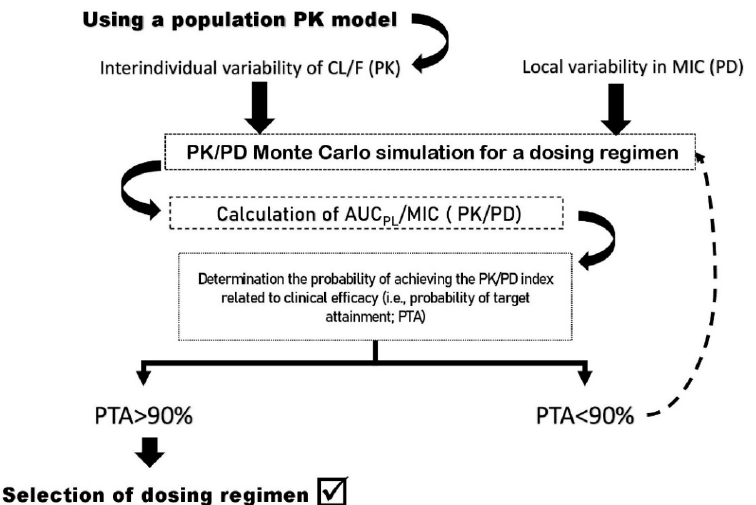
Figure 3. Model-based approach to select FQ dosing regimen based on % probability of target attainment. Scheme of the steps needed to apply PK/PD analysis and Monte Carlo simulation in clinical setting. PK: Pharmacokinetics; PD: Pharmacodynamics; CL: Clearance; F:Biodisponibility; AUC PL : area under the plasma drug concentration-time curve from time 0–24 h; MIC: minimum inhibitory concentration; PTA: Probability of target attainment.